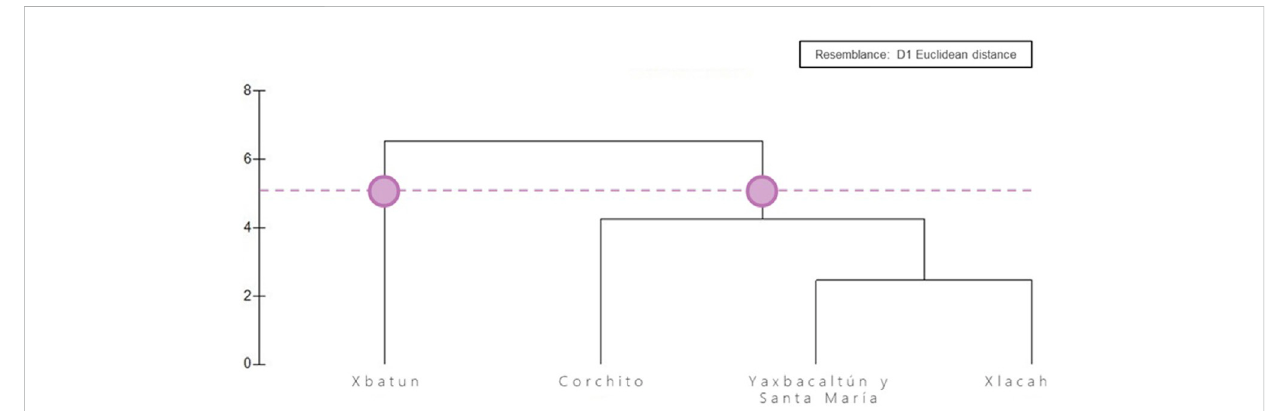
FIGURE 6 Cluster analysis. A cut-off value of 5 was used to determine the degree of dissimilarity between the sites with relation to the presence or absence of the detected species. The Euclidean distance was chosen as a measure of